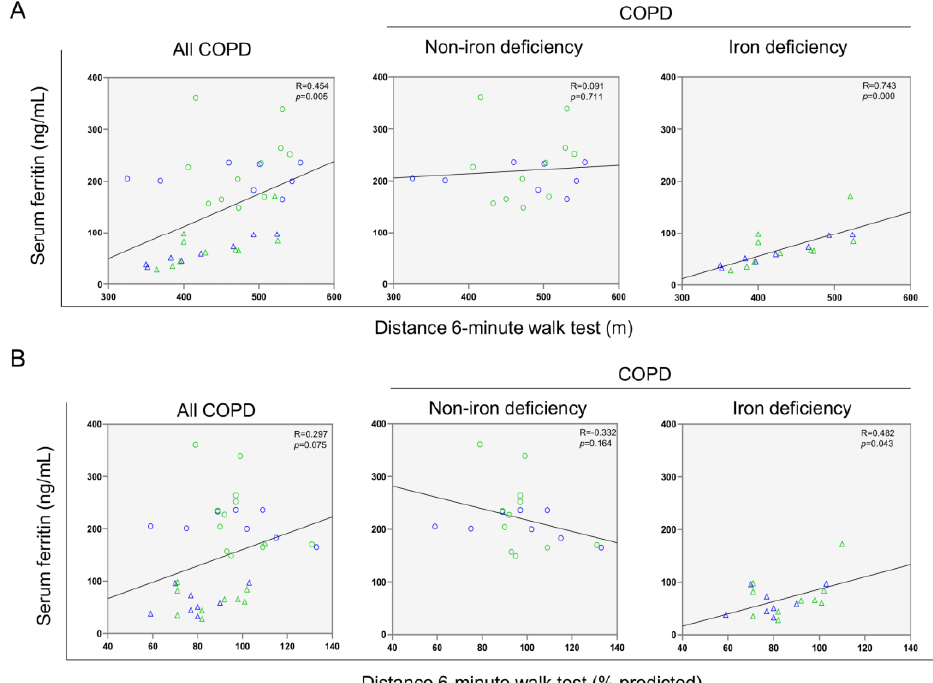
Figure 4. Scatter plots representation of correlations between serum ferritin levels and six-minute walk test distance (m) ( A ) and six-minute walk test distance (% predicted) ( B ) in all COPD patients ( left panels), non-iron deficiency ( middle panels) and iron deficiency ( right panels) COPD patients. In the scatter plots, the green color dots or triangles indicate male patients in either study group, while the blue color dots or triangles indicate female patients in the same groups. Definition of abbreviations: COPD, chronic obstructive pulmonary disease.